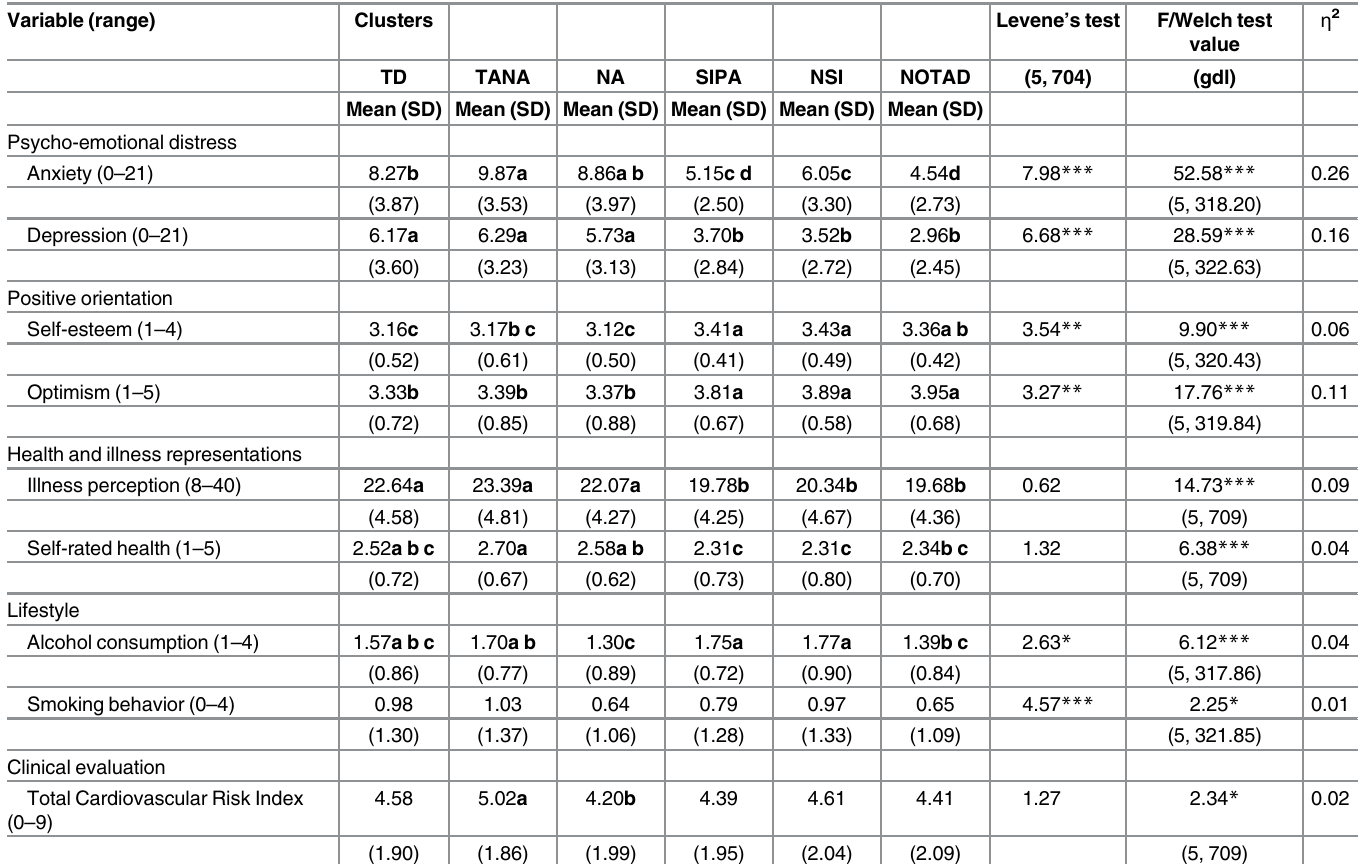
Table 5. Means and standard deviation for psycho-emotional distress, positive orientation, health and illness representations, lifestyle (Alcohol consumption and Smoking behavior), and clinical evaluation (Total Cardiovascular Risk Index) for the final six-cluster solution. Results from com- parisons and post-hoc